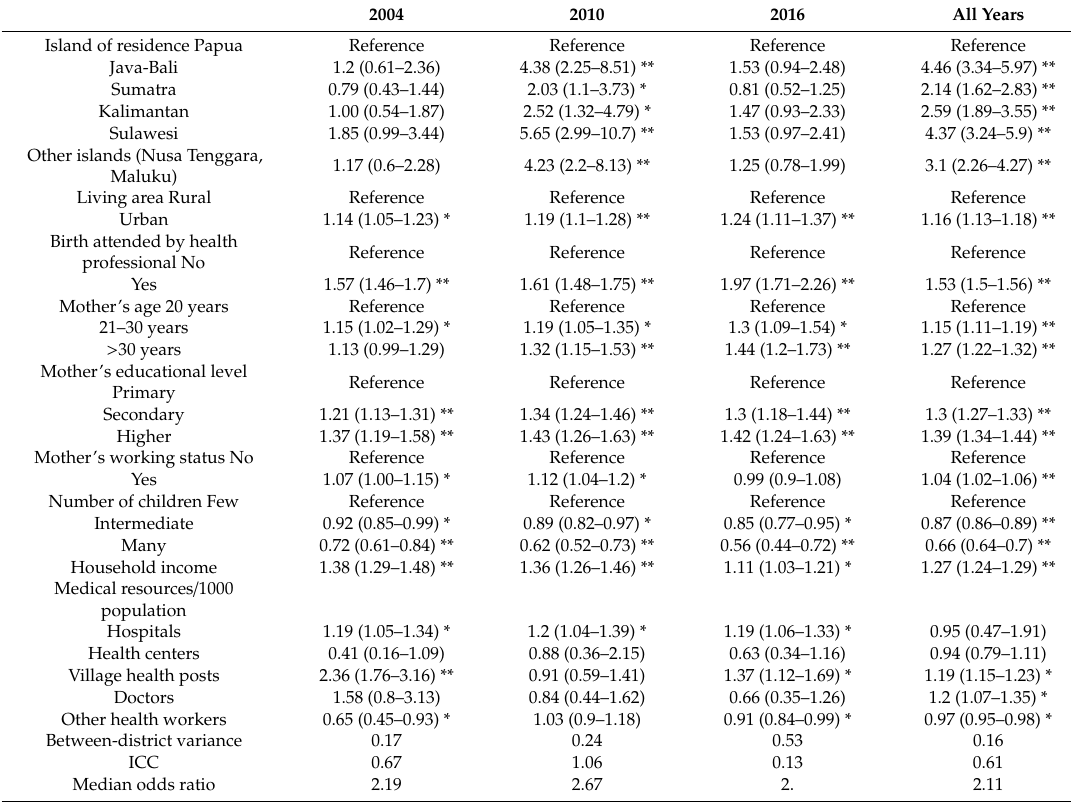
Table 1. Determinants of children’s DTP immunization status.